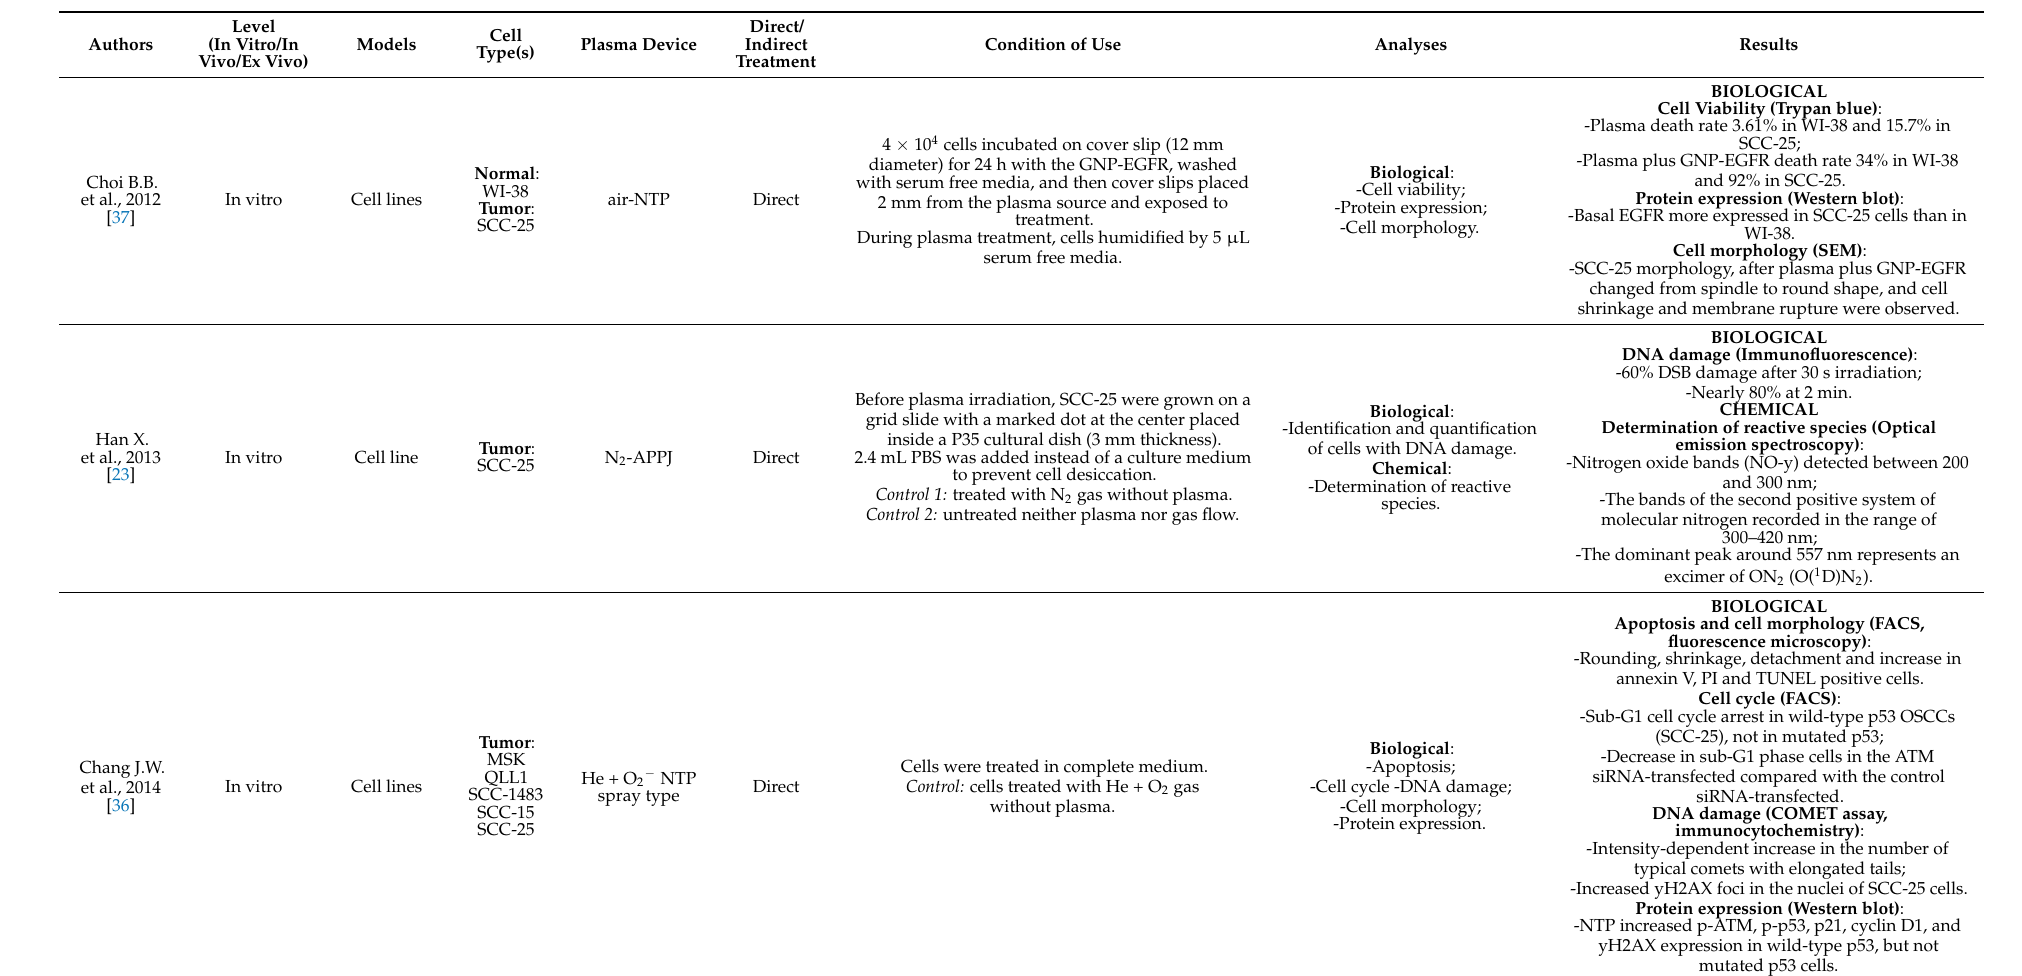
Table 2. Characteristics of preclinical